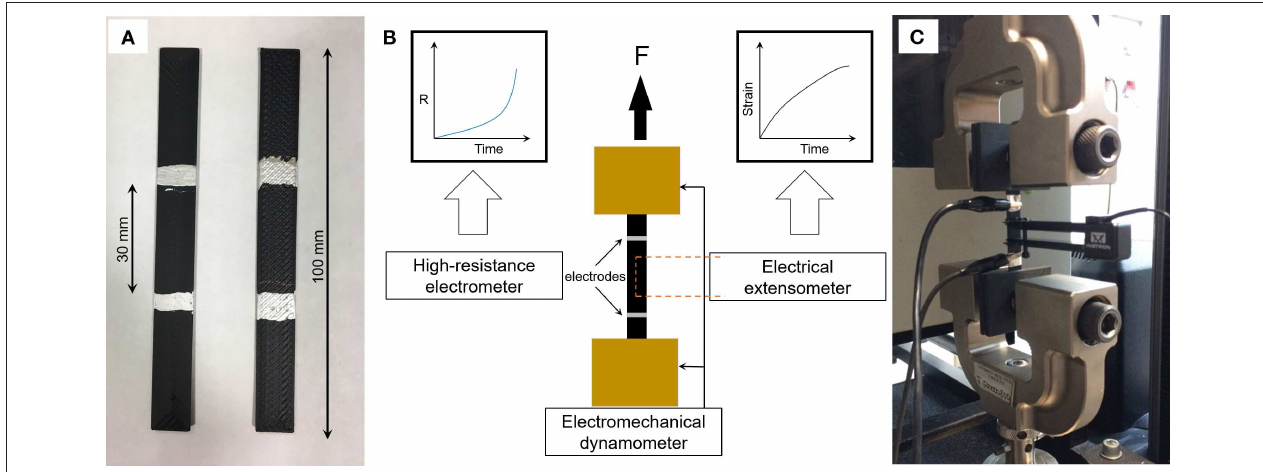
FIGURE 2 | Experimental setup for the strain monitoring: (A) Specimens after conductive paint; (B) Schematic of experimental setup; and (C) Actual setup in tensile test.